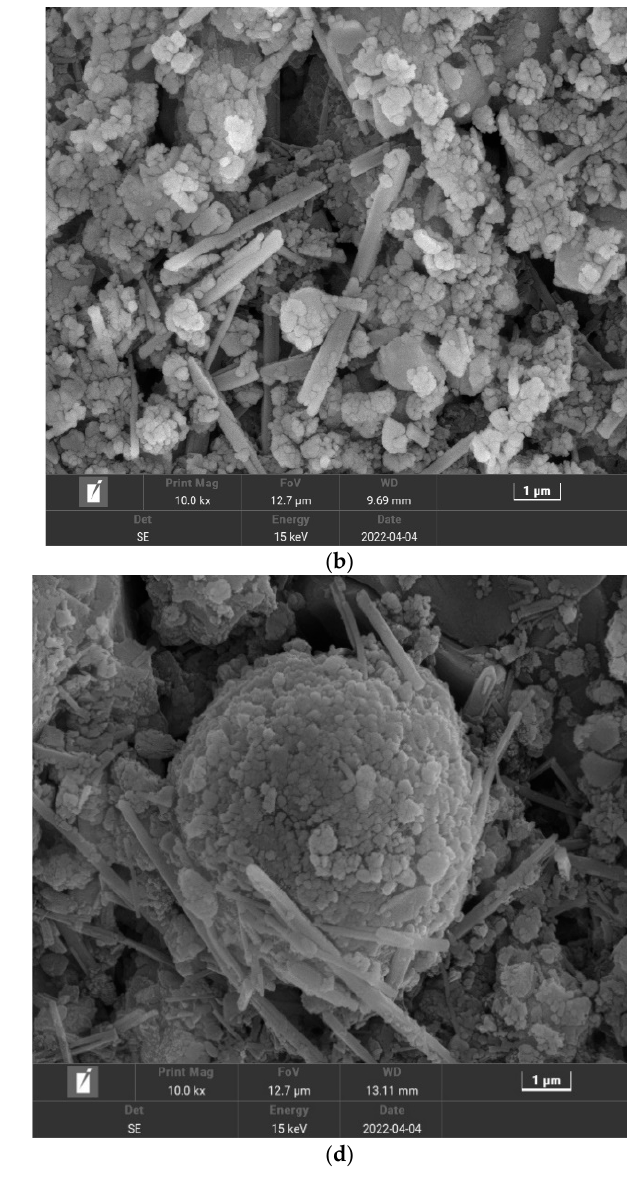
Figure 12. Microstructure of cement mortar with NM: ( a ) 1% NM; ( b ) 2% NM; ( c ) 4% NM; ( d ) 8% NM.